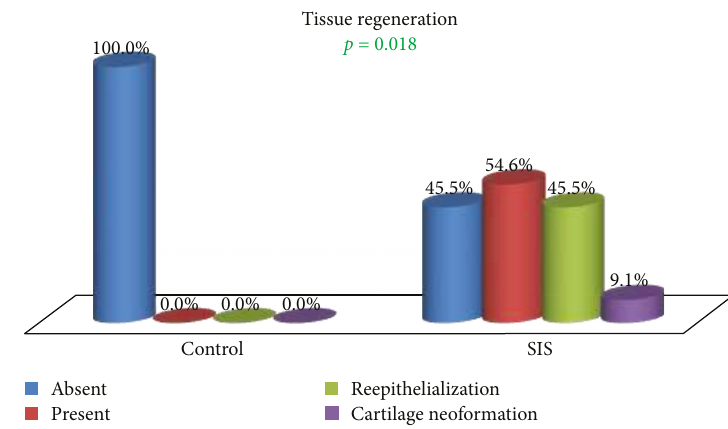
Figure 16: Tissue regeneration: group comparison.